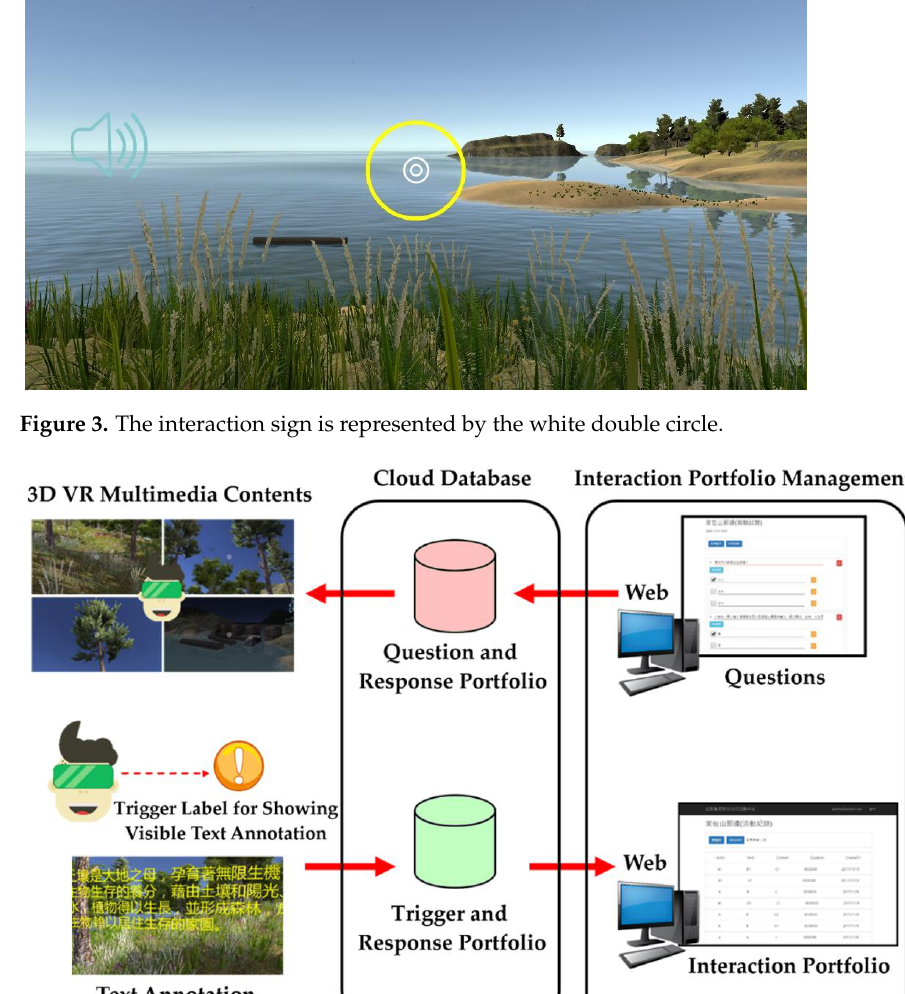
Figure 3. The interaction sign is represented by the white double circle.